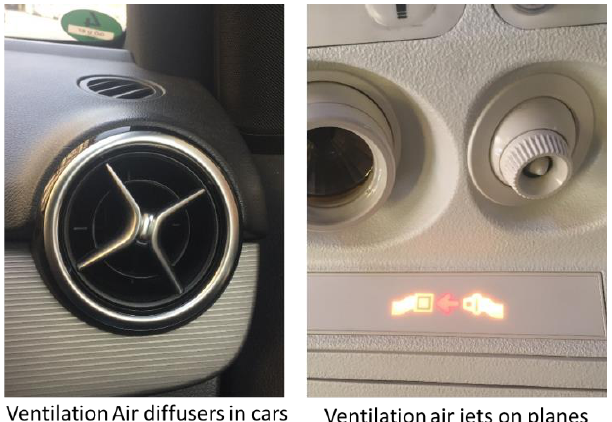
Figure A1. Examples of common microclimate ventilation nozzle diffusers.